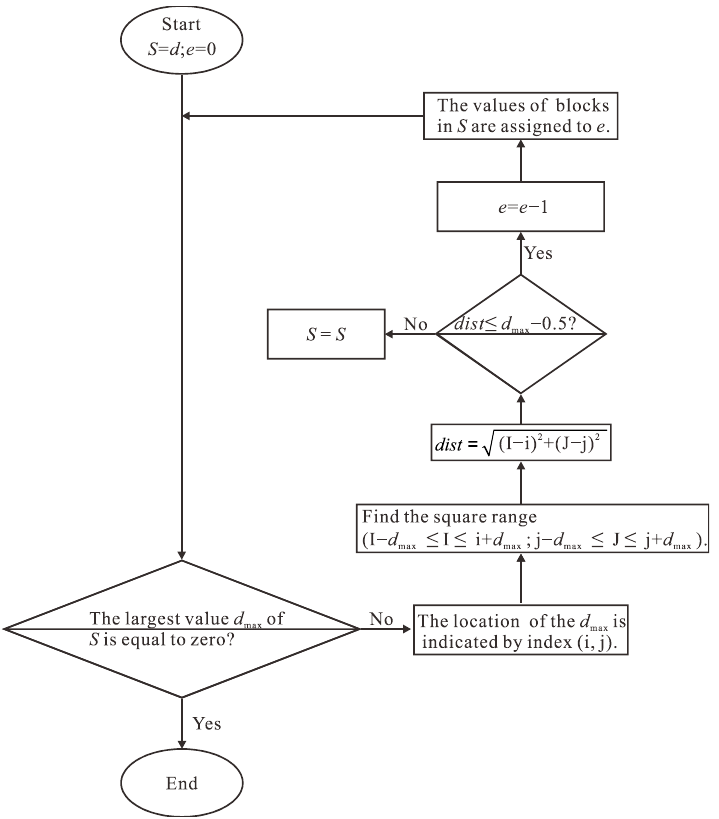
Figure 6. Flowchart of the algorithm for showing the calculation process of S . Here, S represents the different pore regions and the number of partitioned regions is represented by e .